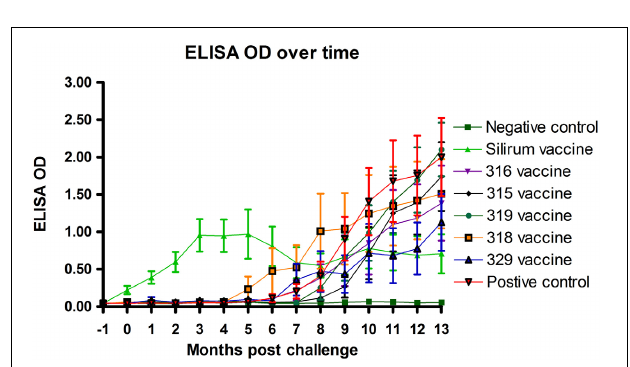
FIGURE 6 | Parachek® ELISA optical density (OD) readings over time. Note the almost immediate increase in ELISA OD for the Silirum® vaccinated group, the progressive increase in ELISA OD in most vaccine groups beginning around 5 months post-challenge and the leveling off of the Silirum® vaccinated group OD values at 9–13 months post-challenge. (Error bars represent standard error of the mean, − 1 is baseline bleeding, 0 is challenge date and 1–13 represents months post-challenge).